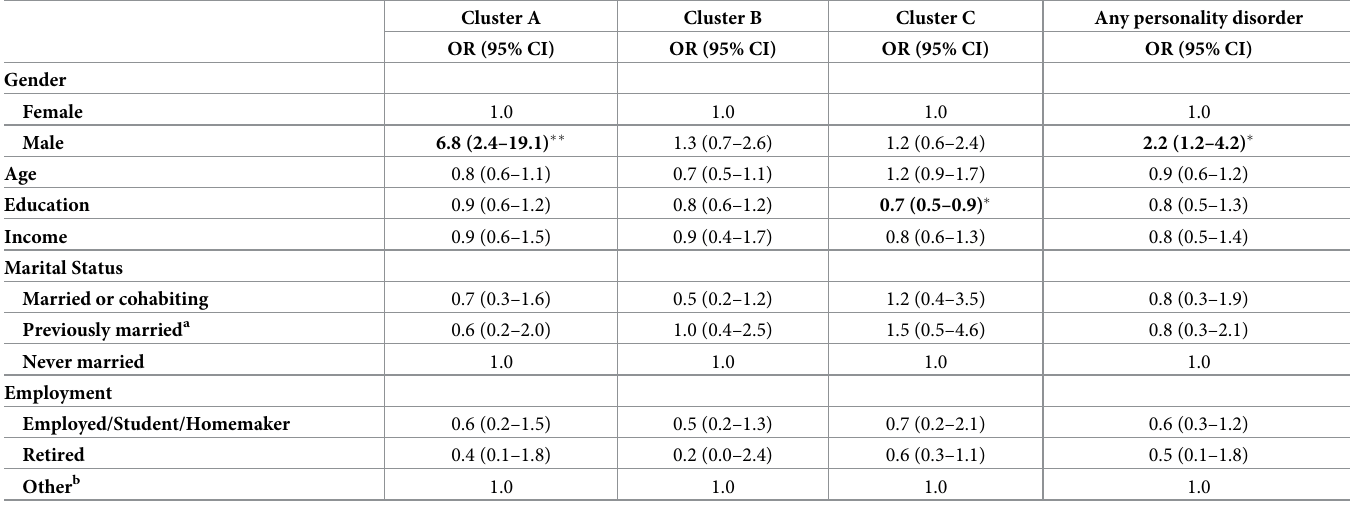
Table 2. Sociodemographic predictors of personality disorders in the Sao Paulo Metropolitan Area.